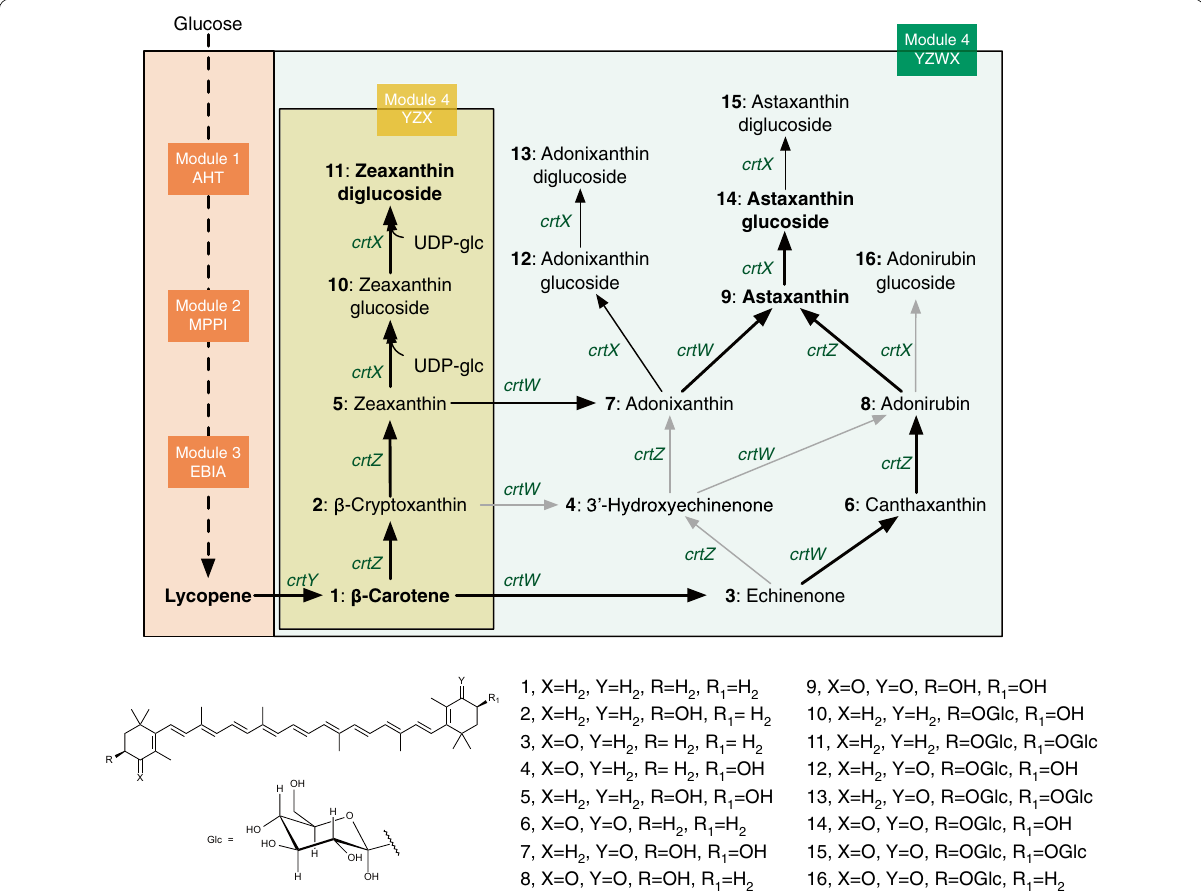
Fig. 1 Biosynthetic pathway of carotenoid glucosides. The biosynthetic pathway: module 1 AHT, including atoB , hmgS and thmgR ; module 2 MPPI, including mevk , pmk , pmd and idi ; module 3 EBIA, including crtEBI and ispA (Zhang et al. 2018); and module 4 YZX or YZWX, including crtYZX or crtYZWX . Dashed arrow indicates multiple enzymatic steps. The glycosylation of all carotenoids required UDP-glucose (UDP-glc), here we only used zeaxanthin glucosides as representatives. The genes expressed encode the following enzymes: crtY , lycopene beta-cyclase; crtW , β-carotene ketolase; crtZ , β-carotene hydroxylase; crtX , zeaxanthin glucosyltransferase (ZGT). Thicker and thinner arrows represent the higher and lower carbon flux, respectively; gray arrows represent that the metabolites (e.g., β-cryptoxanthin-β-D-glucoside and 3 ′ -hydroxyechinenone-β-D-glucoside) were not detected in our